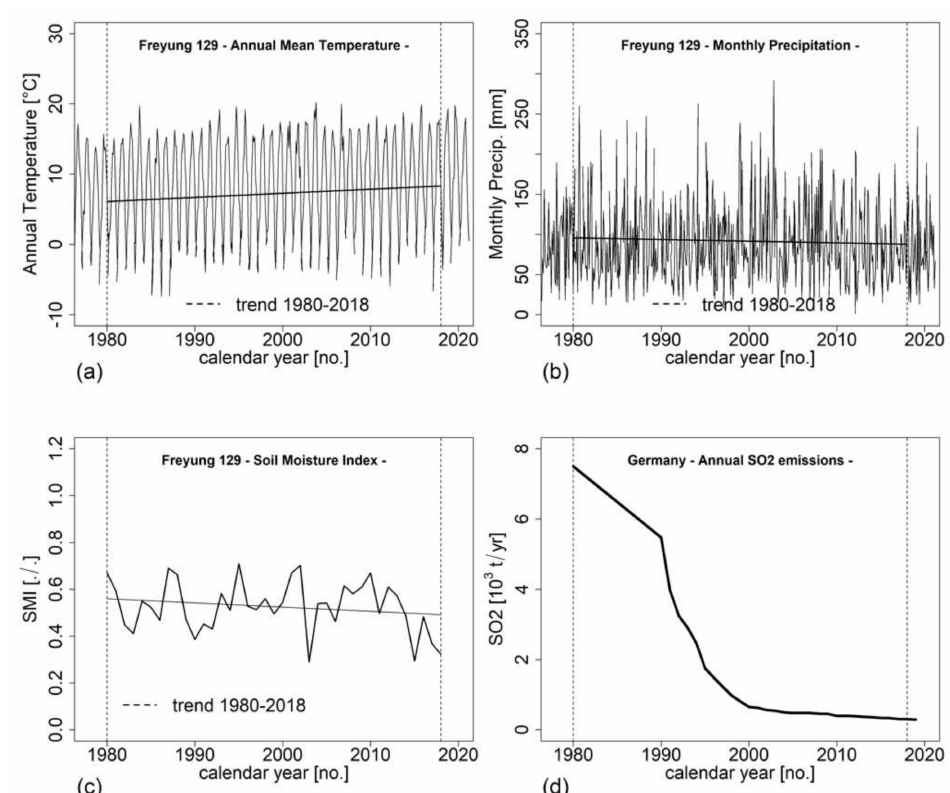
Figure 2. Development of ( a ) annual mean temperature, ( b ) precipitation, ( c ) soil moisture index, and ( d ) SO 2 -emission in Germany in 103 t/yr from 1980–2018 in the study area according to [56,57]. The slopes for the trendlines are in ( a ) 0.058 ( ± 0.028) p -tail < 0.05, ( b ) − 0.2075 ( ± 0.2099) p -tail = 0.323,